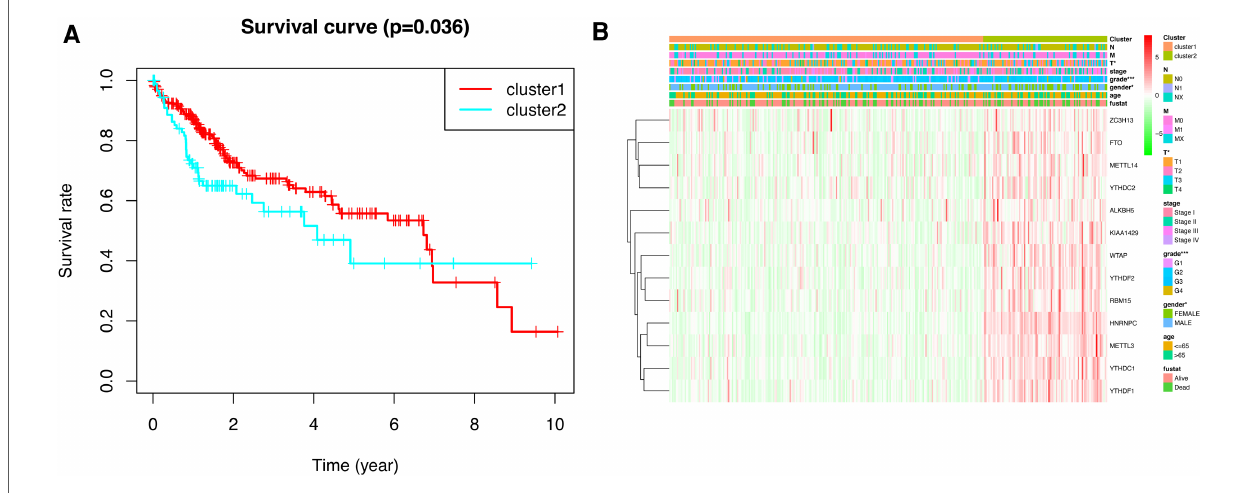
FIGURE 3 Kaplan – Meier survival analysis and heatmap of expression of m6A methylation-related genes. ( A ) Kaplan – Meier survival analysis of overall survival in different subgroups. ( B ) Heatmap of expression of m6A methylation-related genes and clinicopathological features between different